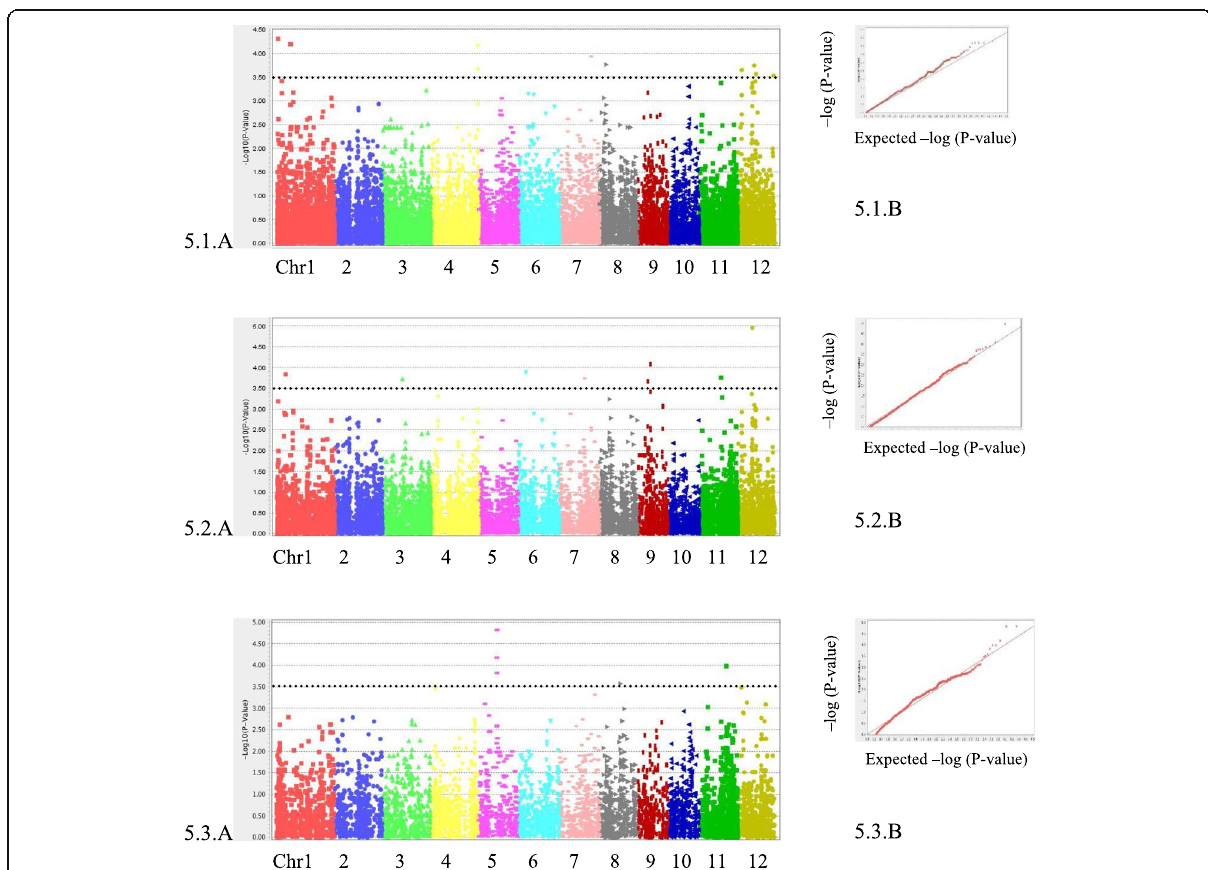
Fig. 5 GWAS for the effects of exogenous JA on SHL. Manhattan plot ( a ) and Quantile-quantile plot ( b ) for shoot length in a whole (5.1) panel or Indica (5.2) or Japonica (5.3) sub-panel. The black line indicates the suggestive significance threshold, p =